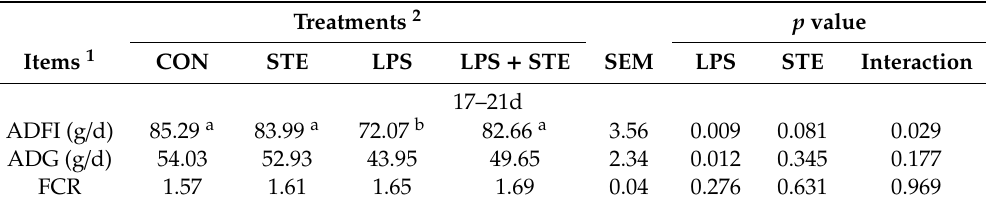
Table 3. Effects of stevioside supplementation on the growth performance of LPS- (lipopolysaccharide) challenged broilers.